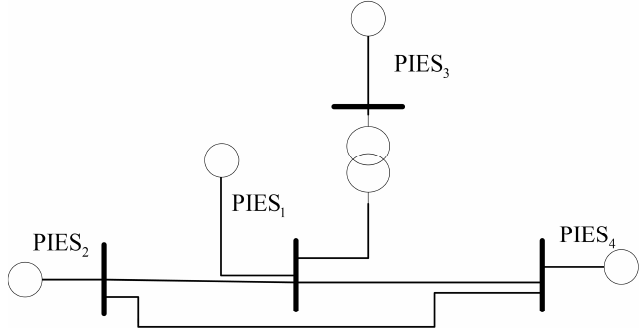
Figure 4. RIESG topology diagram.